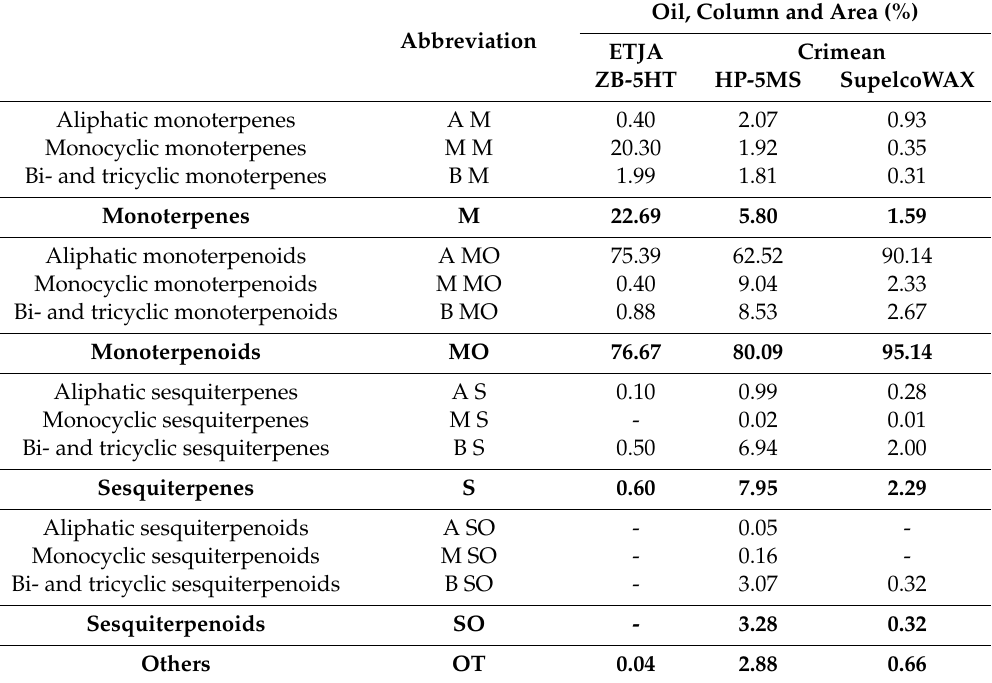
Table 4. The list of terpenes in the tested lavender